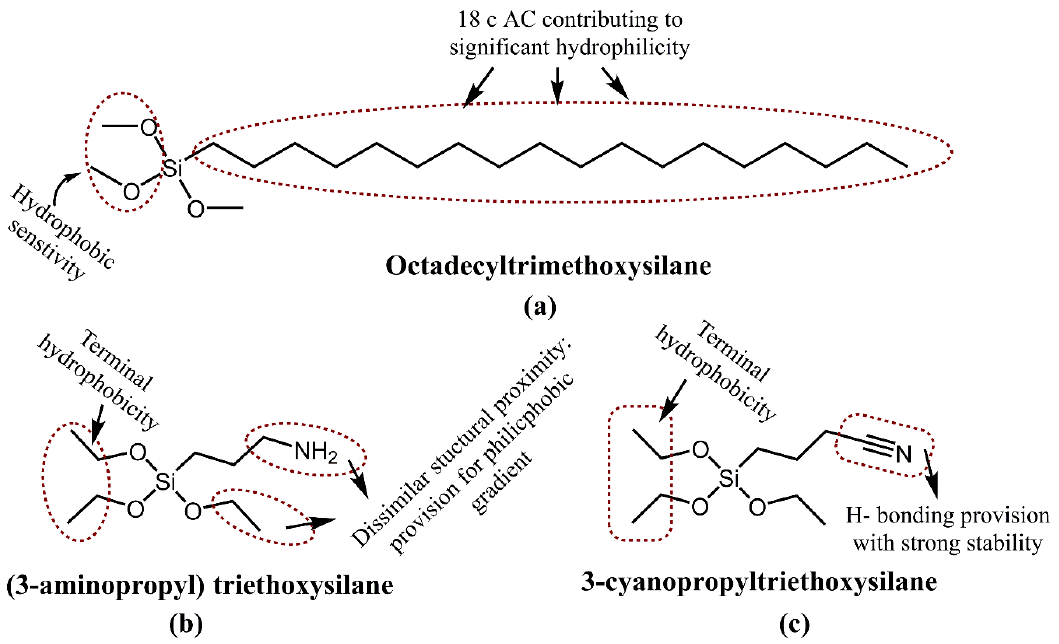
Figure 5. Structural distinctions of octadecyltrimethoxysilane (OTMS), (3-aminopropyl) triethoxysilane (APTES) and 3-cyanopropyltriethoxysilane (CPTES). Unlike APTES and CPTES, the unblocked hydrophobicity in OTMS confers a greater monodispersing ability driven by steric stabilization. The APTES and CPTEs are both only partially hydrophilic, with terminal – NH 2 and N substitutions.